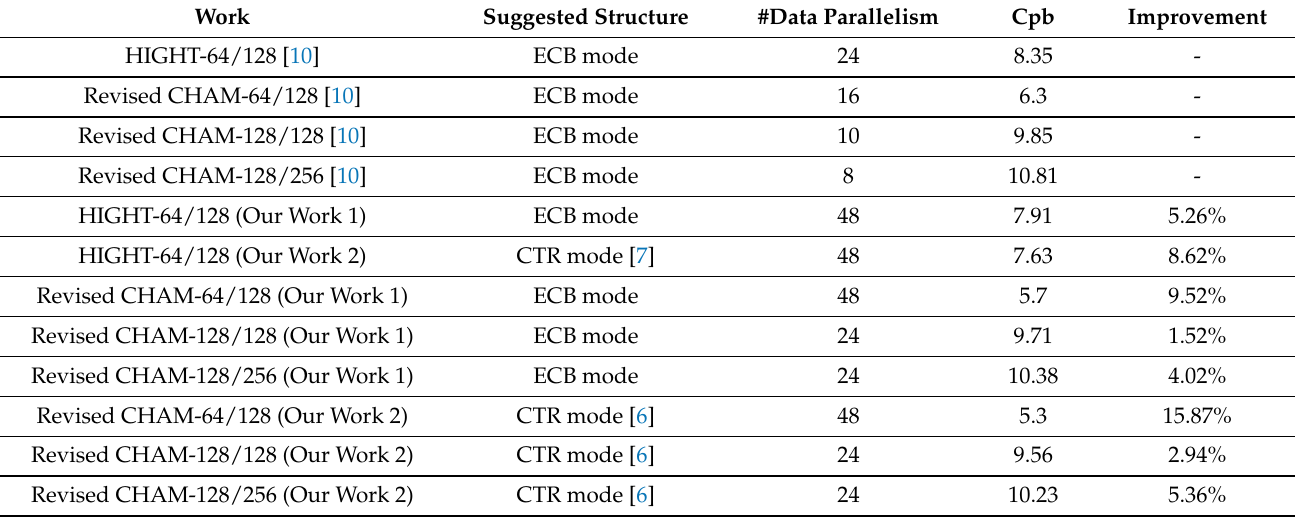
Table 6. Running time comparison of HIGHT and revised CHAM implementation in the ARMv8 architecture. (Our Work 1: Proposed parallel implementation, Our Work 2: Proposed CTR mode optimization, and #Data parallelism: the number of encryptions performed simultaneously on NEON engine, Cpb: Clock per byte, and Improvement: Improved performance compared to previous